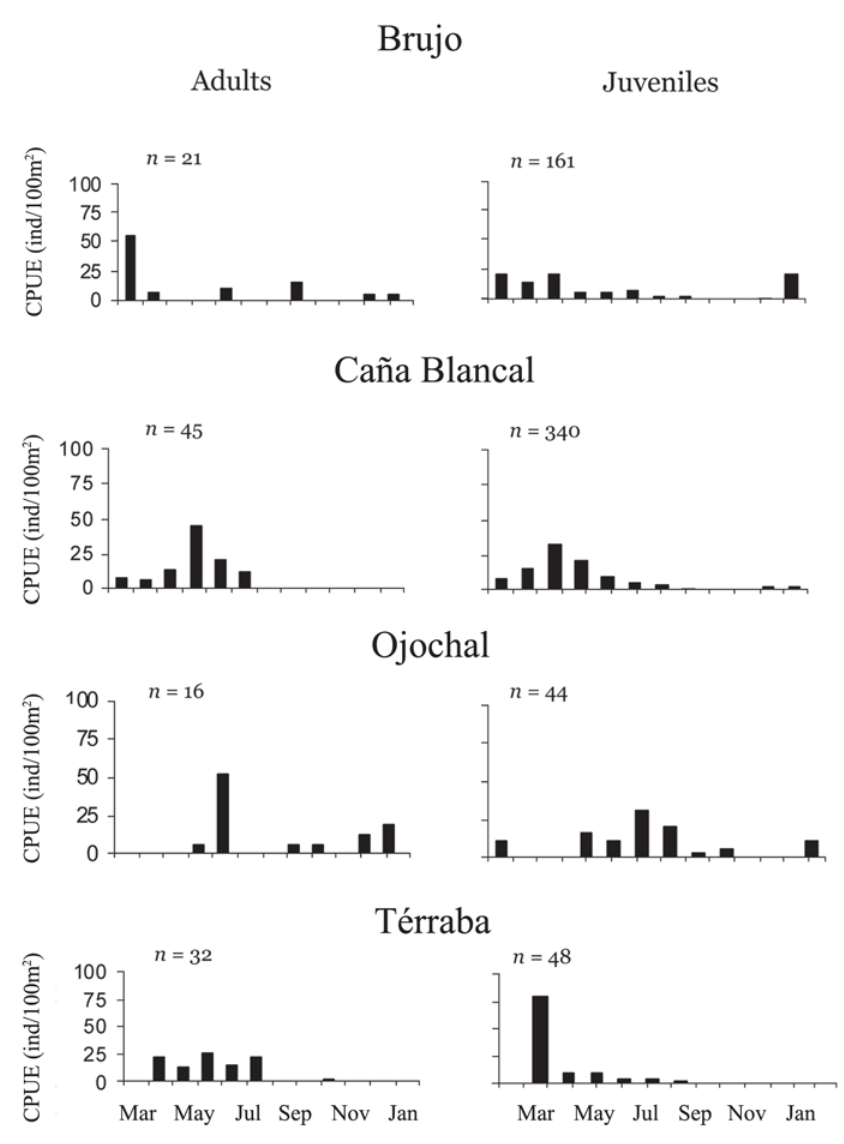
Fig. 6. Capture per unit effort (CPUE) by month for Brycon behreae juveniles and adults in the Térraba River and three